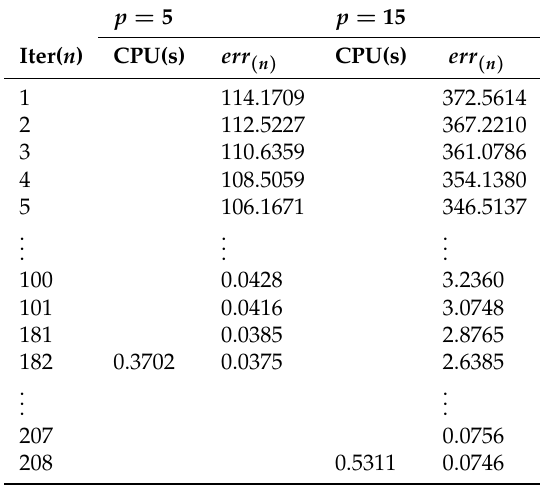
Table 2. Performance of Algorithm 1 for N = 8 and different p = q with TOL = 10 − 4 .